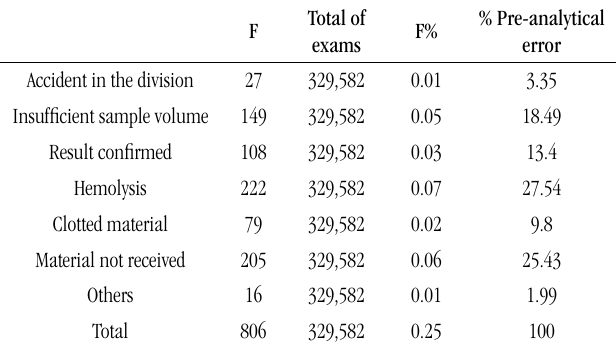
tABLE – Absolute and relative error frequency, by cause